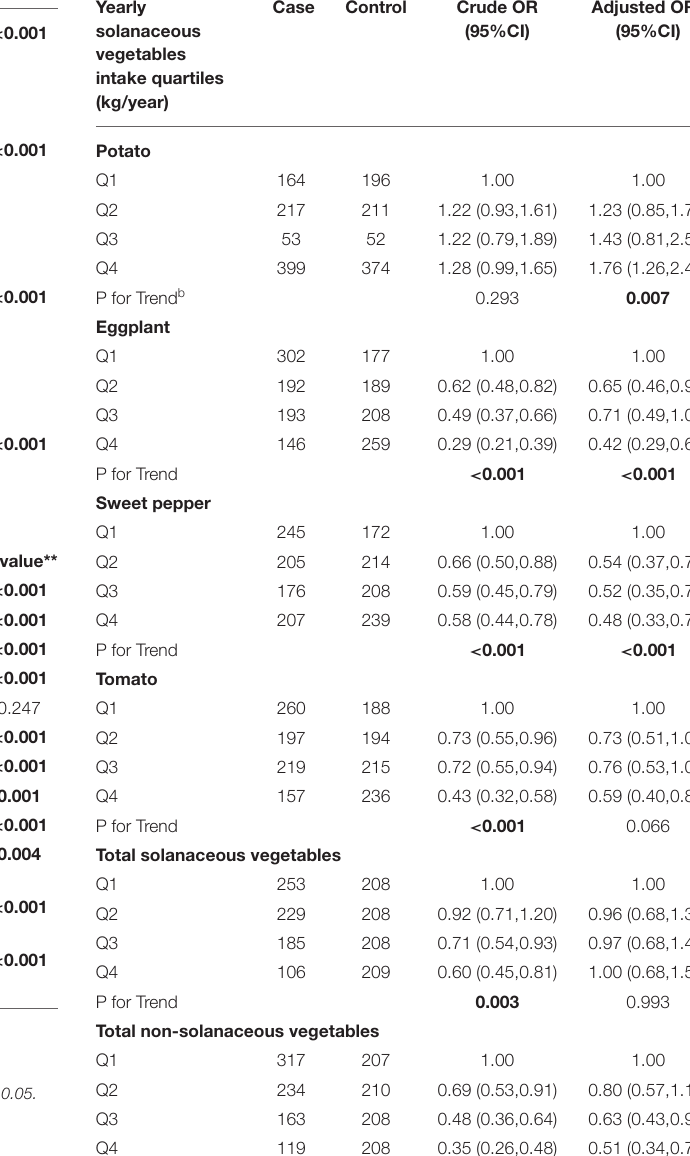
TABLE 2 | Dietary habits and selected dietary intake of all subjects. Dietary habits